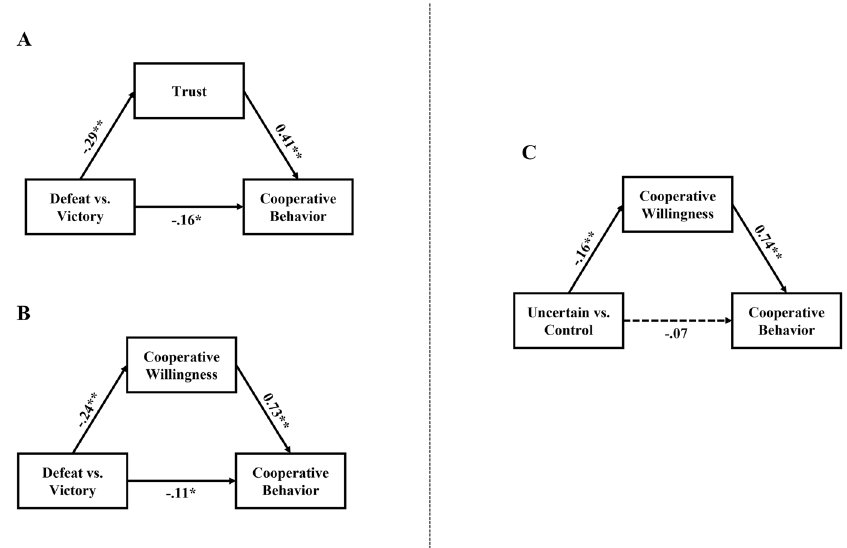
Figure 4. Mediation results. The effect of competition-outcome feedback on participants’ cooperative behavior toward their opponents is mediated through trust ( A ) and the willingness to cooperate ( B ). In contrast, the effect of competition without relative performance feedback on participants’ cooperative behavior toward their opponents is mediated through the willingness to cooperate ( C ). The model refers to behavior when there was a high risk of incurring personal costs (α = 1.4). Nonsignificant mediating variables were excluded for presentation clarity. Standardized regression coefficients ( B ) were presented on the significant paths as denoted by solid lines. No significant paths were represented by dash lines. * p < 0.05, ** p <